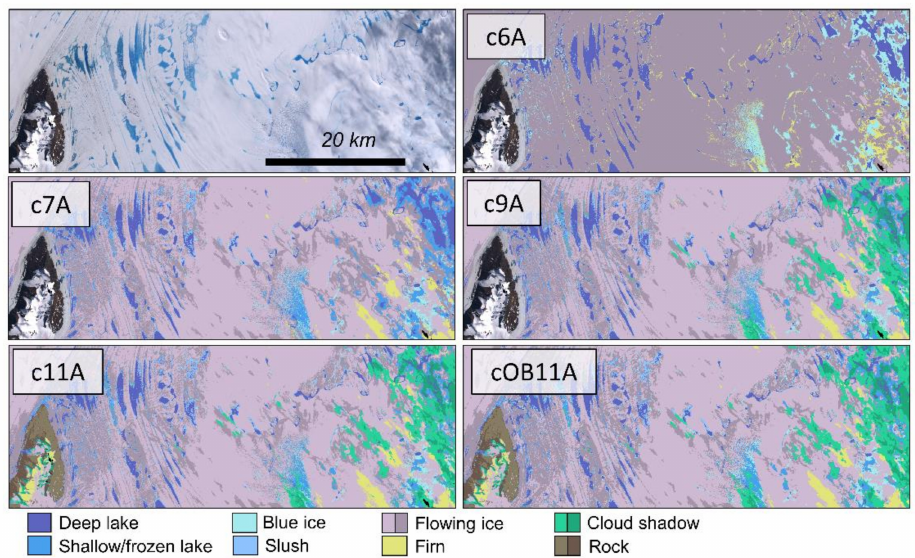
Figure 4. Results for di ff erent trained classifiers (described in Table 1), applied to scene LC08_L1GT_128111_20170118. A rock mask was applied prior to classification when using the c6A, c7A, and c9A classifiers but not for c11A or